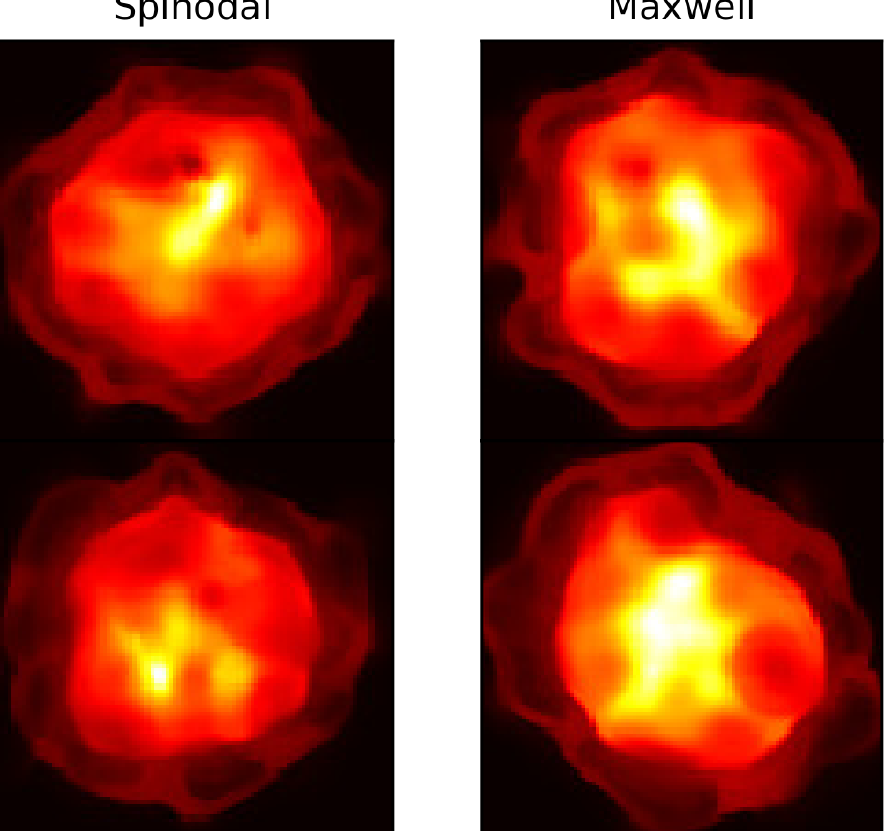
Figure 2 . Example images of the normalized transverse density distributions. 20 000 of these individual Pb+Pb collision events are generated with the spinodal EoS (left) and Maxwell Eos (right). These images are used as input to train a convolutional neural